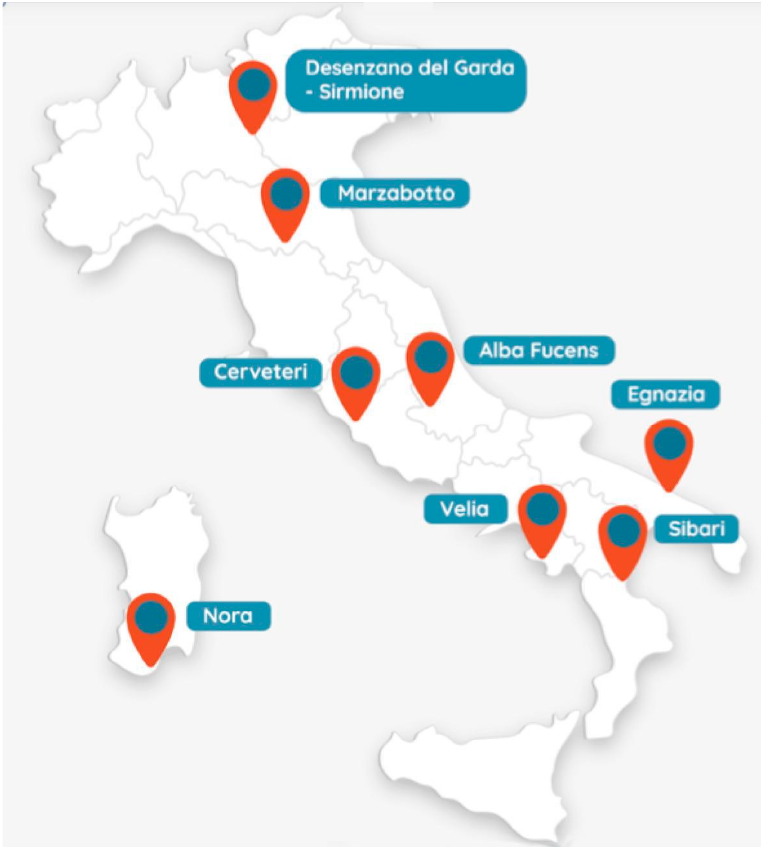
Figure 1. Map of Italy showing the location of the eight archaeological sites considered in the e-Archeo project.